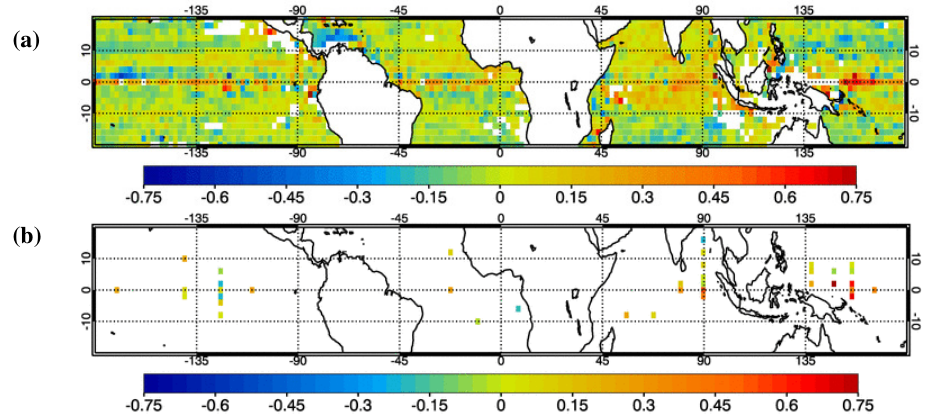
Figure 2: Zonal velocity errors (observed-modelled), in 2º bins, over the range 20S to Fig. 2. Zonal velocity errors (observed-modelled), in 2 ◦ bins, over the range 20 ◦ S to 20 ◦ N for (a) the drifter-derived current validation and (b) the moored buoy